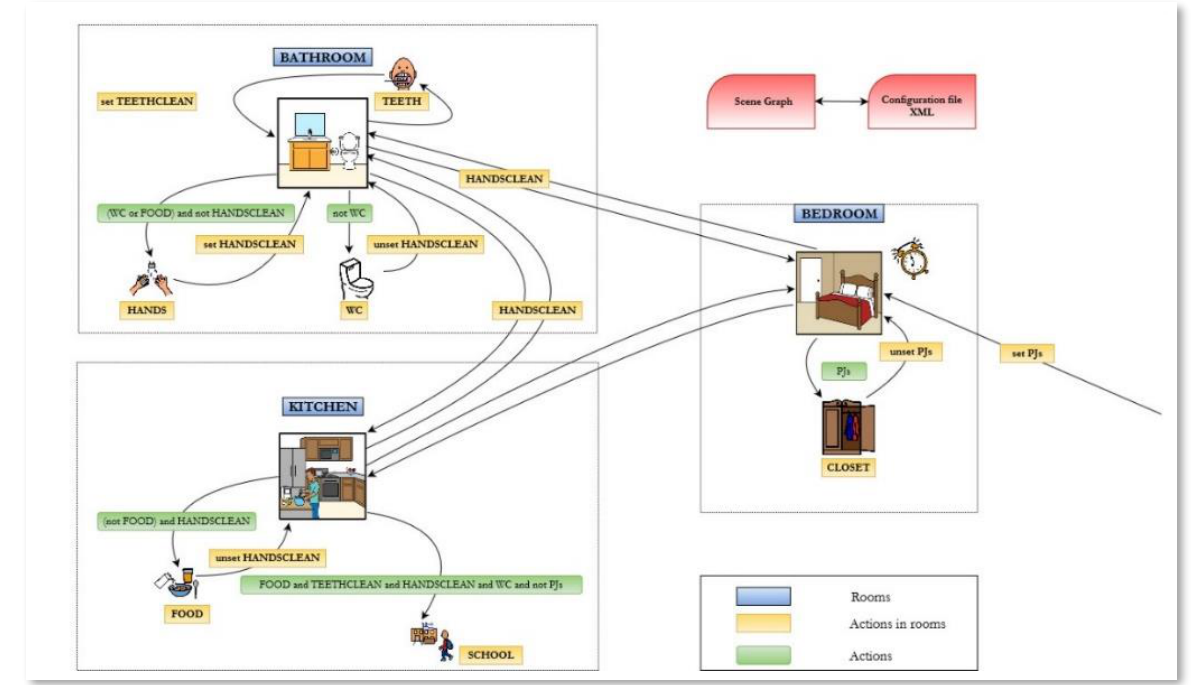
Figure 26. Scene graph of VR